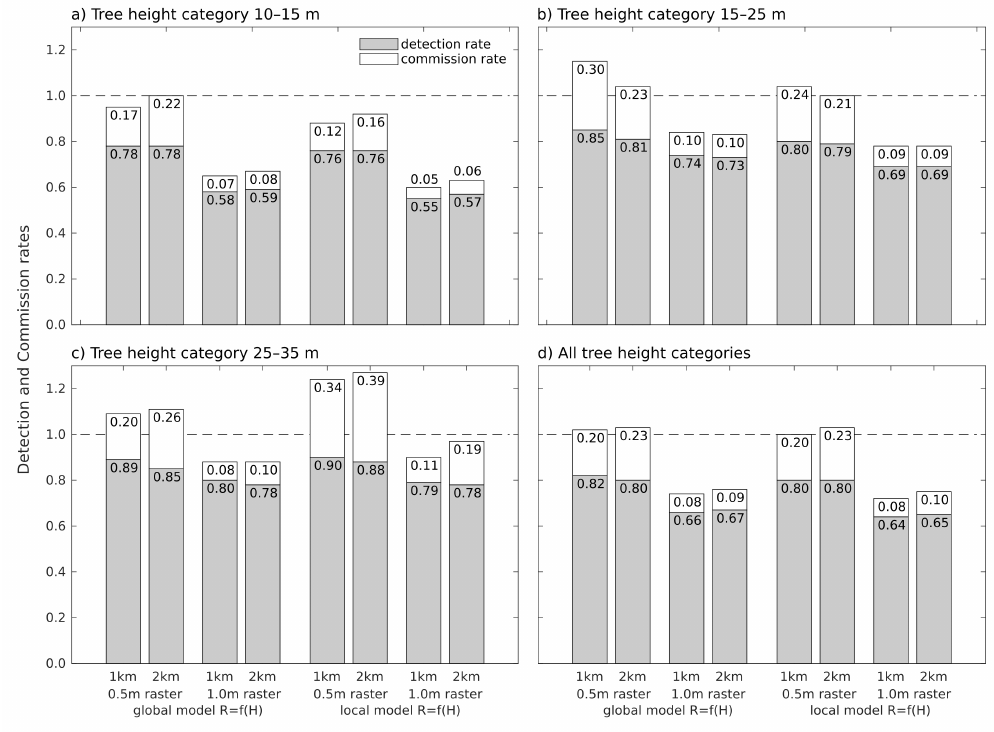
Figure 5. Verification of tree detection. Detection and commission rates calculated for three forest height categories ( a – c ) and all categories together ( d ) using manual identification of